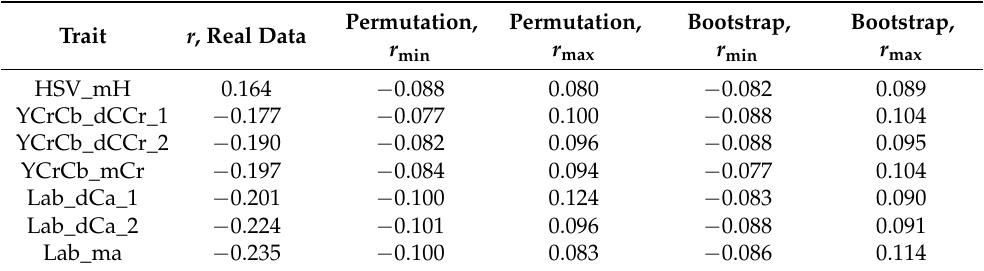
Table 2. Grain color traits with the most pronounced correlation with germination values, estimates of the Pearson correlation coefficients for them in the real sample ( r ) and their minimum ( r min ) and maximum ( r max ) values for the permutation and bootstrap tests.